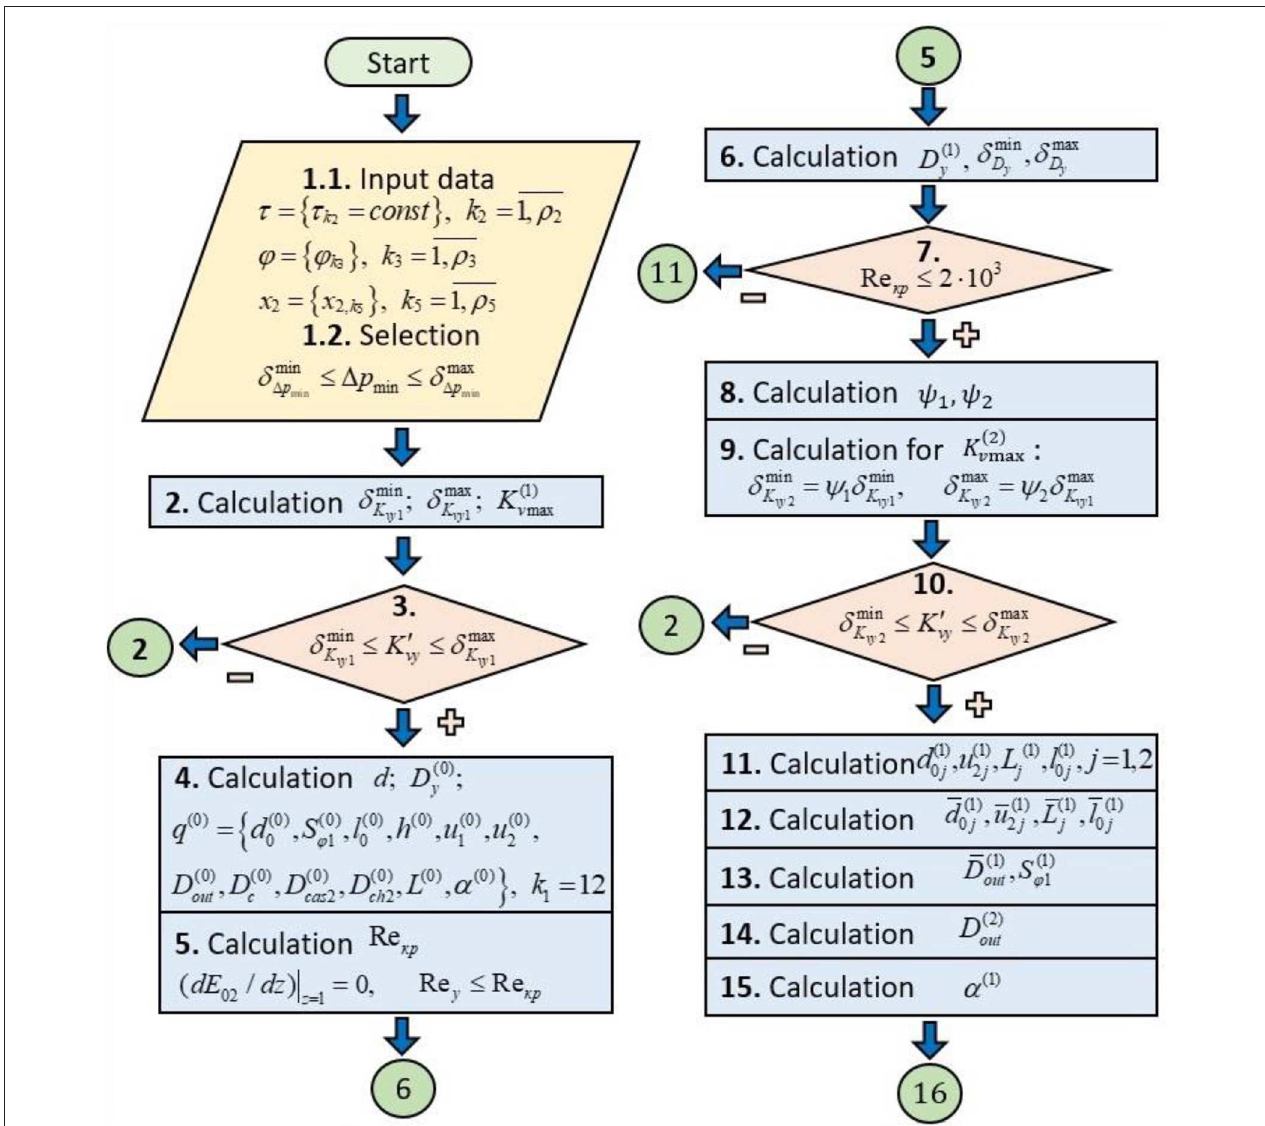
FIGURE 2 | Conventional block diagram of the calculation of the design parameters of the axial valve separator with the external location of the locking member (Part 1).